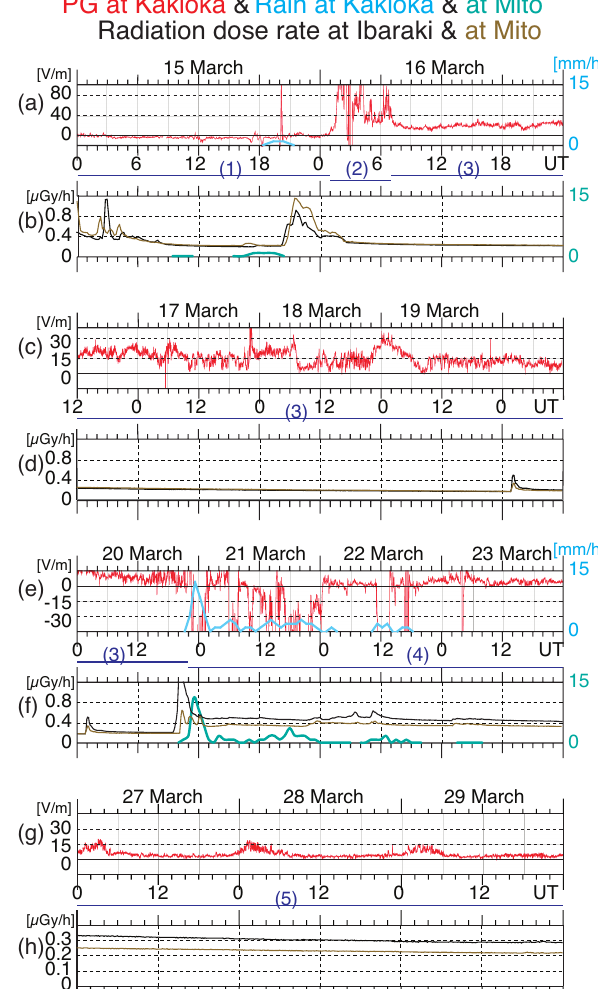
Fig. 3. PG at Kakioka (red line), rainfall at Kakioka (blue line), radiation dose rate at Ibaraki-cho (black line), radiation dose rate at Mito (brown line), and rainfall at Mito (blue-green line) in the same format as Fig. 1 except for the duration and scales: (a) and (b) 15–16 March (48h); (c) and (d) 16–20 March (96h); (e) and (f) 20–23 March (96h); and (g) and (h) 27–29 March (72h). Mito is located 15km north of Ibaraki-cho (Fig. 2). The ordinate scale for the radiation curves (b) , (d) , (f) , and (h) is linear instead of logarithmic as in Fig. 1, and scaling for (a) and (h) and offset for (e) are different from those for the other respective panels. Num- bers (1)–(5) in each panel denotes the same periods as (1)–(5) in Fig. 1, respectively. Note that local noon at Kakioka is near 03UT.